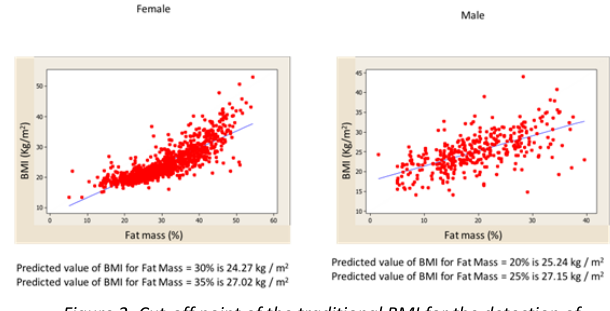
Figure 2: Cut-off point of the traditional BMI for the detection of obesity in men and women of the sample studied, considering percentages of body fat for the classification of overweight and obesity of 20% and 25% and 30% and 35% for men and women, respectively.